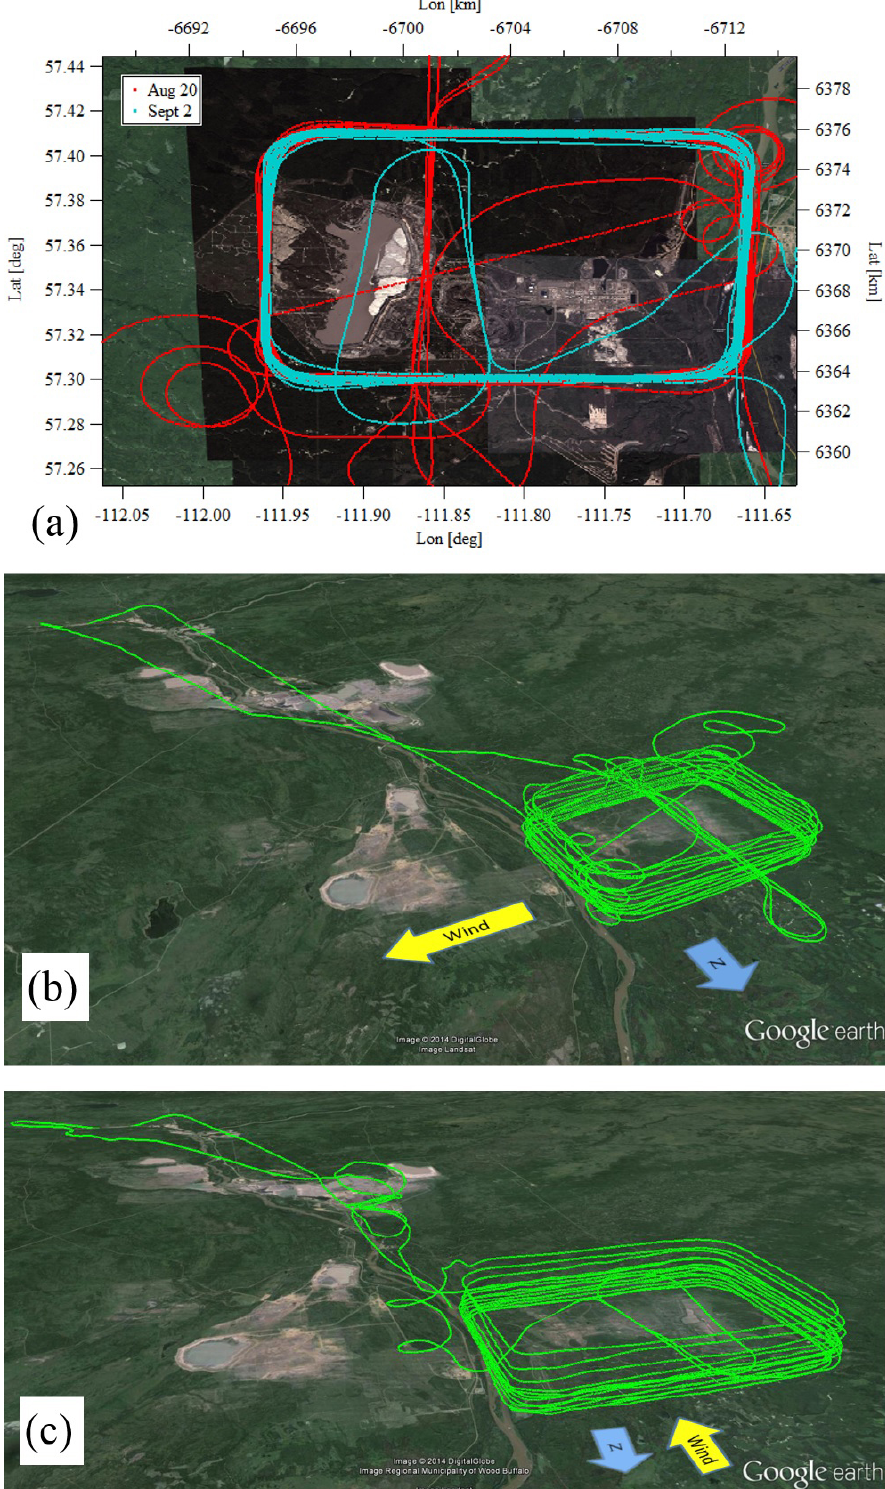
Figure 1. A composite Google image (a) shows the path of the 20 August (red) and 2 September (cyan) flights. Google Earth images demonstrate the path of (b) the 20 August flight and (c) the 2 September flight. The yellow arrow shows wind direction; the blue arrow shows north. Map image data provided by CNES/SPOT, Digital Globe, and